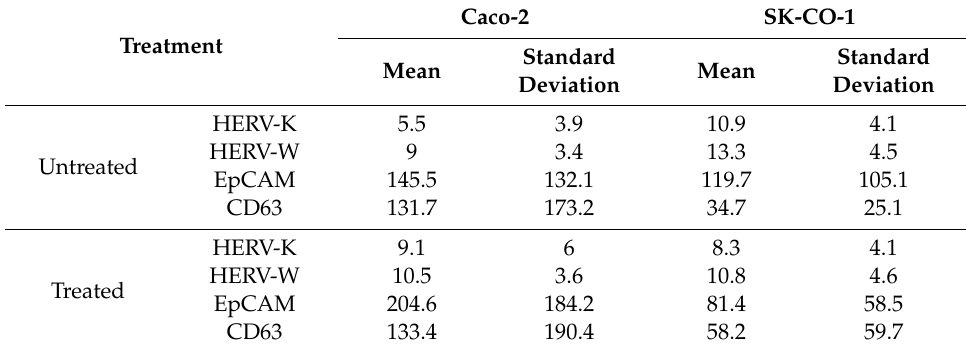
Table 3. Characterization of EV concentrations (count / mL) in Caco-2 an SK-CO1 cells. Caco-2 SK-CO-1 Treatment Standard Standard Mean Mean Deviation Deviation Untreated HERV-K Treated